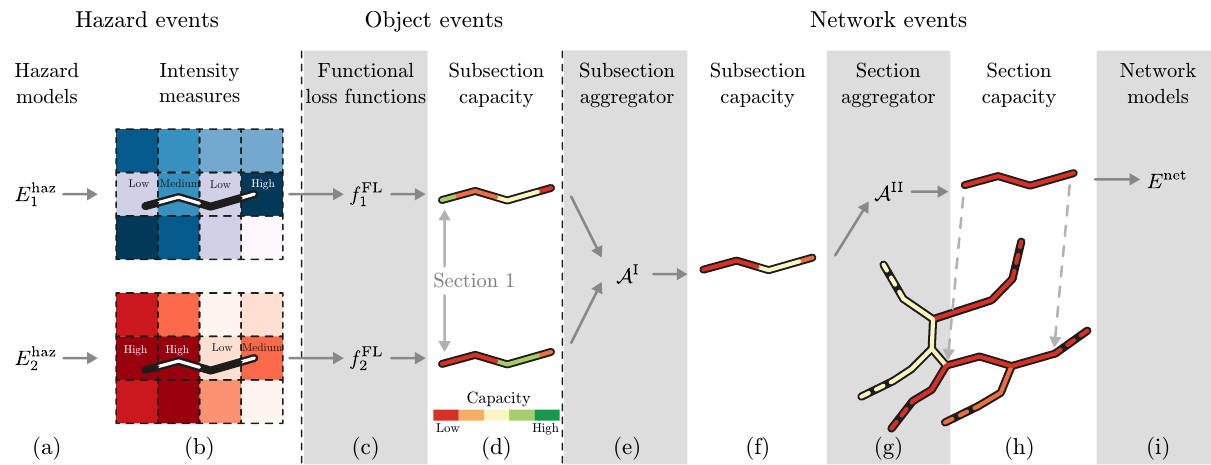
Figure 6. The hazard events (a) were represented in the form of a spatially distributed grid where the intensity measures change for each cell (b) . Each road section of the network had to be split up according to this grid, which resulted in a set of subsections. This process was also previously illustrated in Fig. 3. In this specific example, the considered section is split into four subsections (b) . The intensities are then processed independently for each of these subsections. For each intensity measure, the expected functional loss (i.e., speed reduction, capacity reduction) for each subsection is determined using computed functional loss functions f FL are the resulting functional losses that are encoded in the colors of the subsections. A subsection aggregator A I (e) is executed for each subsection and combines all functional loss values derived from different hazard events into a single value (f) . This aggregator simply takes the maximum functional loss values. Finally, a section aggregator A II (g) combines the functional losses of the subsections into a single functional loss for the section (h) . Losses at the section level are then used in the network model (i) . (This figure was adapted from Heitzler et al.,